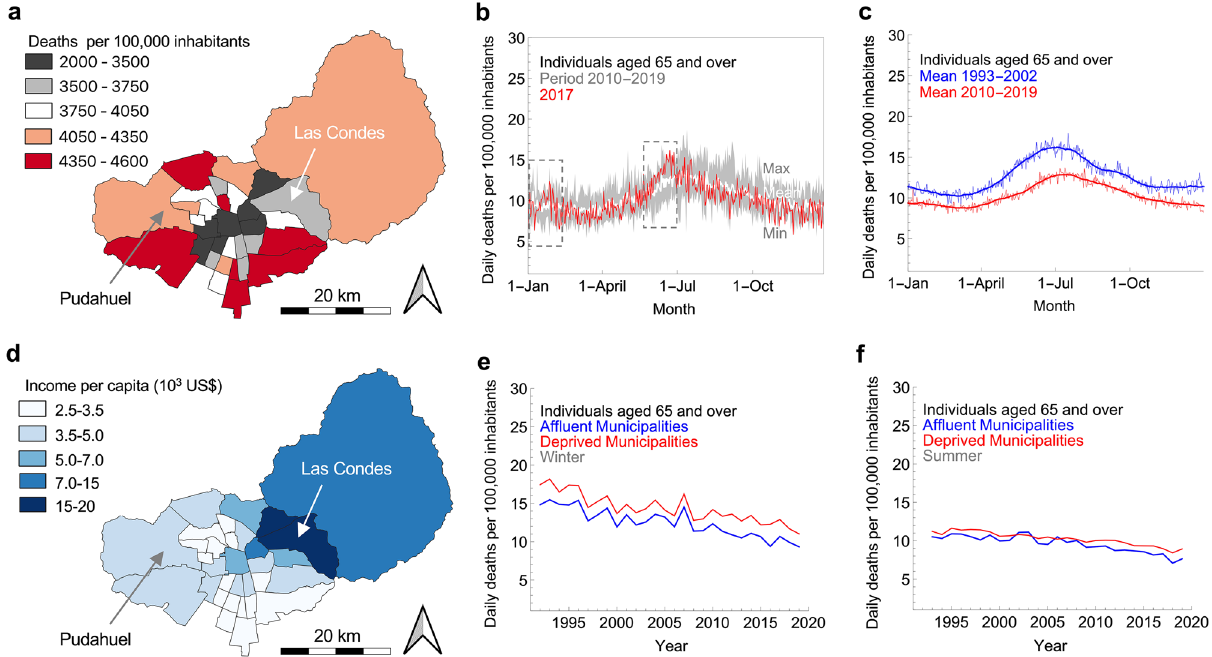
Figure 1. While socioeconomic inequalities generally drive disparities in the mortality rate, the gap between rich and poor considerably narrows during summer. ( a ) Annual mortality rate (number of annual deaths per 100,000 population) in individuals aged 65 and over across Santiago, averaged over the period 2010–2019. Mortality from all causes was used in this study. Among the more than 50 municipalities of Santiago, central and northeastern municipalities generally exhibit considerably fewer annual deaths than other municipalities on city outskirts. Despite the larger share of older population in affluent municipalities, deaths of adults (aged 65 + years) per 100,000 population are on an annual basis considerably larger in deprived municipalities. ( b ) Daily mortality rate in inhabitants (aged ≥ 65 years) of Santiago. The gray shading indicates the highest and lowest rates for each day of year (DOY) over the period 2010–2019 while the white line indicates the mean over the same period. The daily mortality rate for 2017 is also shown (red line). The dotted rectangular boxes highlight two periods of considerable excess deaths in 2017, that are likely related to the extremely warm January 2017 and to an outbreak of Influenza A (H3N2) Variant Virus 33 . ( c ) Daily mortality rate in inhabitants (aged ≥ 65 years) of Santiago, averaged over two periods: 1993–2002 (blue line) and 2010–2019 (red line). Bold lines correspond to the 30-day centered moving averages. ( d ) Annual income per capita (2017 US$) across Santiago. Inhabitants of central and northeastern municipalities are considerably wealthier than inhabitants of municipalities on city outskirts. ( e ) Progress of winter mortality rate in inhabitants (aged ≥ 65 years) of affluent (blue line) and deprived (red line) municipalities over the period 1992–2019. Although mortality rates in adults (aged ≥ 65 years) have been reduced by about 30% over the last three decades, the gap between wealthy and disadvantaged adults (aged ≥ 65 years) remains during winter. ( f ) Progress of summer mortality rate in inhabitants (aged ≥ 65 years) of affluent (blue line) and deprived (red line) municipalities over the period 1992–2019. The gap between wealthy and disadvantaged adults (aged ≥ 65 years) narrows considerably during summer. Annual household income data are from the National Socioeconomic Characterization Survey 47 . The mortality rate is based on data from the Department of Statistics and Health Information 48 and the National Statistical Institute 49 . In the case of Figs. e–f, municipalities of Santiago were clustered into two groups according to the socioeconomic status of their inhabitants (Table S1). Inhabitants of affluent municipalities are about 15% of the total population. Plots were generated using Python’s Matplotlib library 50